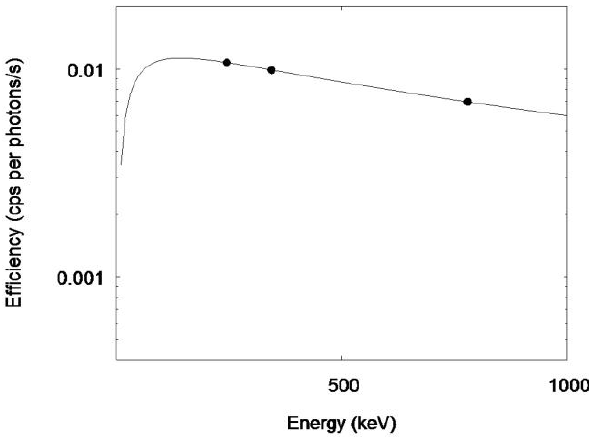
Figure 6. Efficiency curve derived from the 152 Eu point source measurement. Rigid circles indicate calculated values from measurement. The solid line shows the weighted least-squares fitting result.